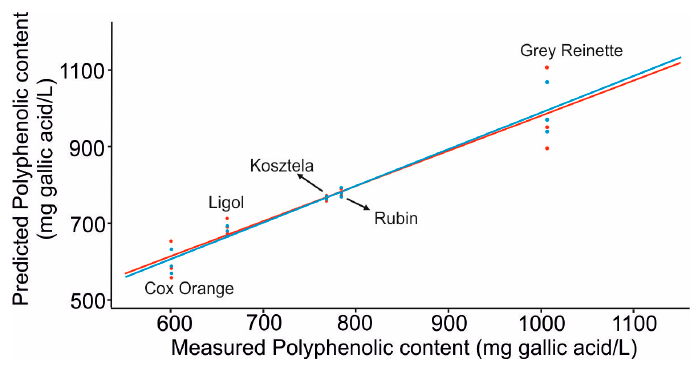
Figure 6. Plot of predicted polyphenolic content obtained with the e-tongue vs. the values of polyphenolic content obtained by the Folin–Ciocalteu method.